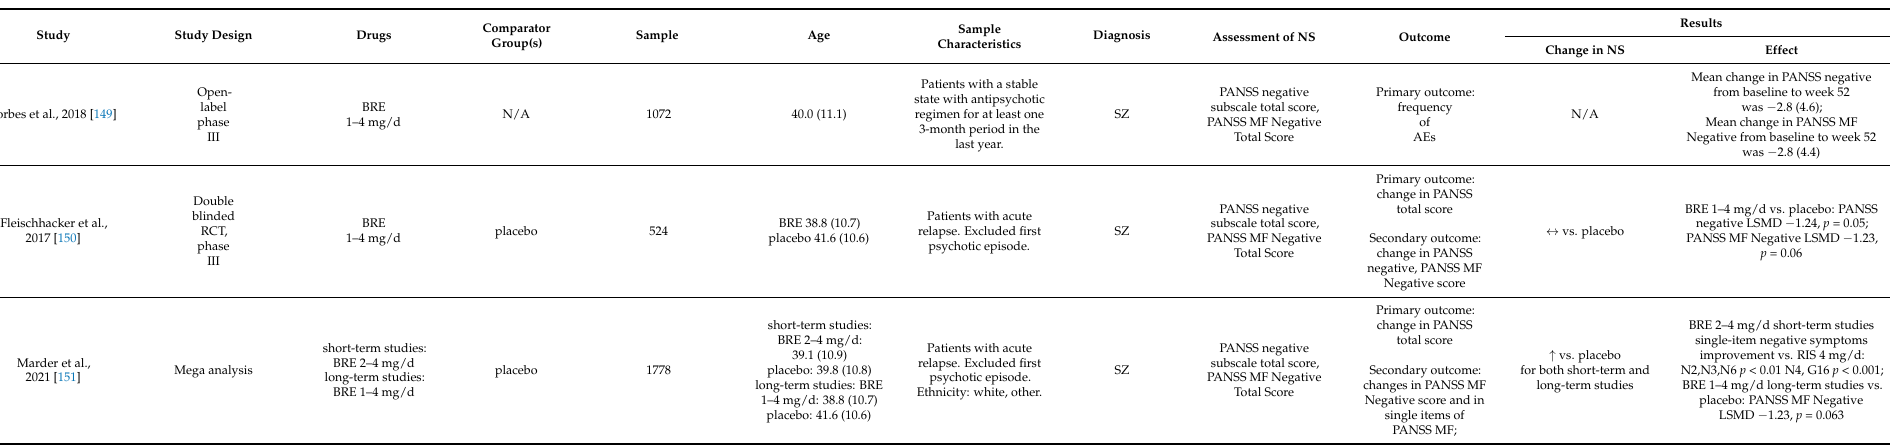
Patientswithacute relapse. Excludedfirst